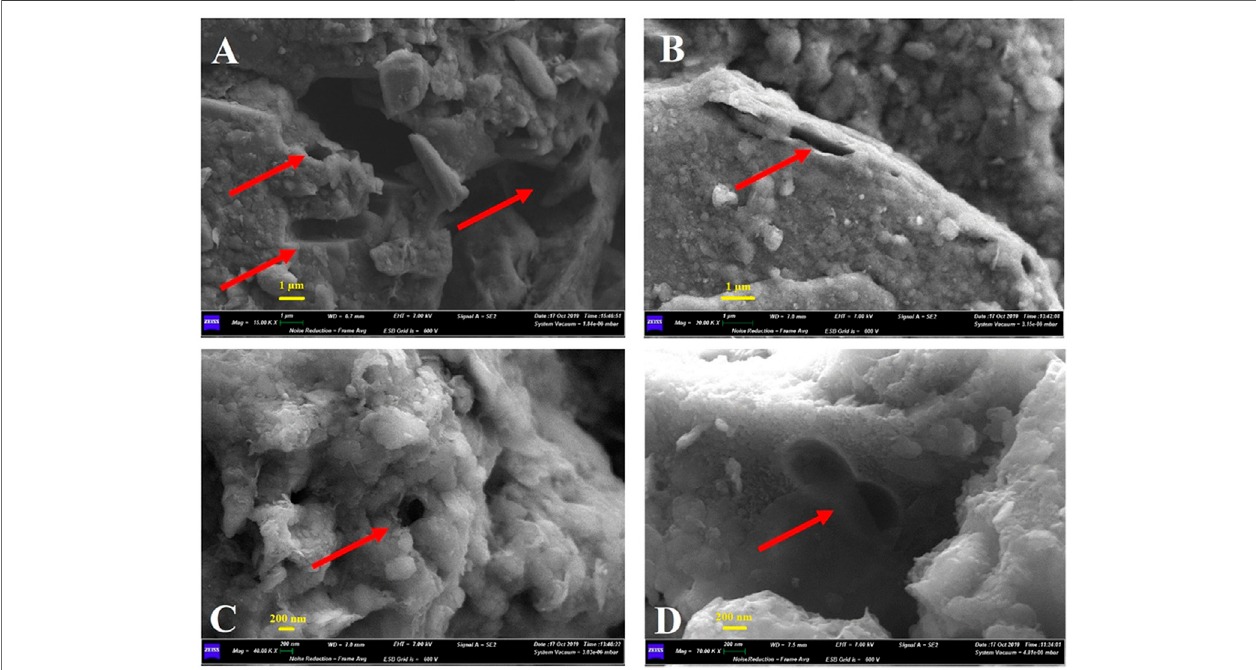
FIGURE1| Micrographsofrocksectionsunderscanningelectronmicroscope; (A) 15 Kmagni fi cationthatshowsclearmicrobialimprintsandpits(scalebar1 µm); (B) 20 K magni fi cation that shows micro borings, identi fi ed asputativepaths carved by microorganisms(scale bar 1 µm); (C) 40 K magni fi cation thatshowsa clear hole on the surface, probably produced by bacterial cells (scale bar 200 nm); (D) 70 K magni fi cation that shows a microbial imprint on the surface, identi fi ed as a putative predivisional cell stage typical of staked bacteria (scale bar 200 nm).